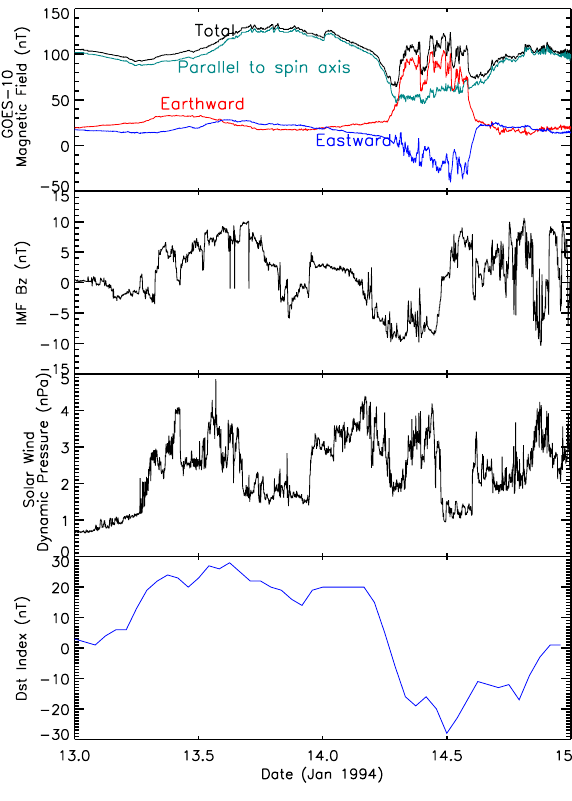
Fig. 3. Geomagnetic field observed by GOES-10(top), IMF Bz (second) and solar wind pressure measured by WIND and D st index from 13 to 14 June